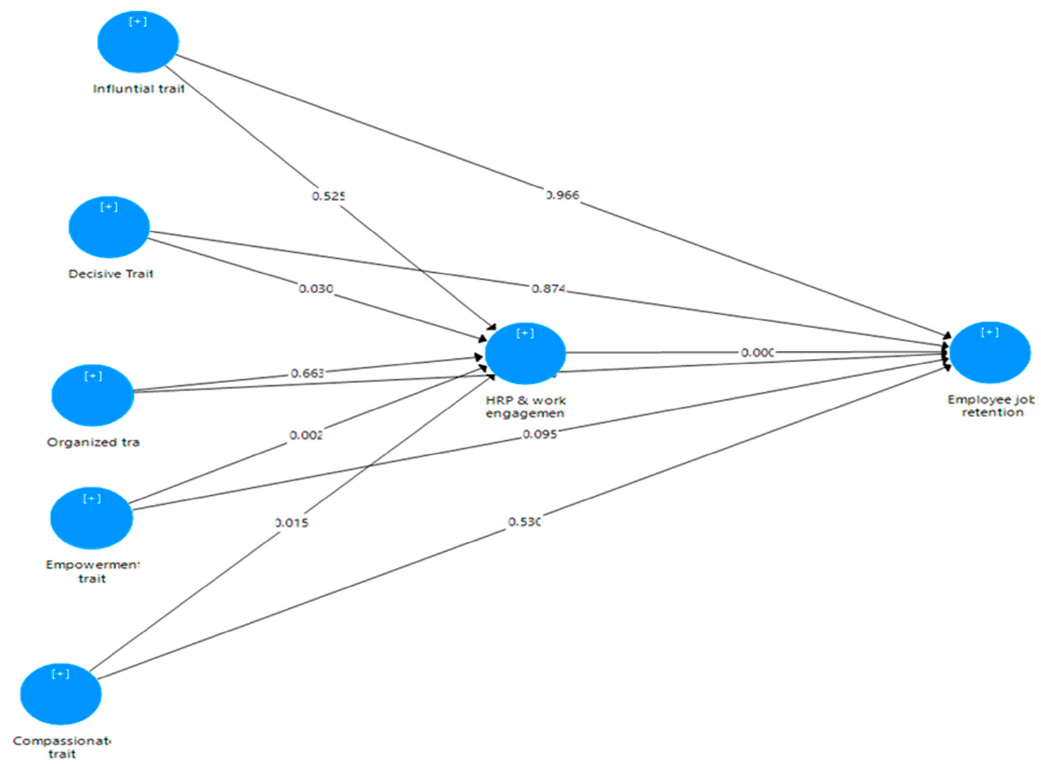
Figure 2. Mediation Effect.